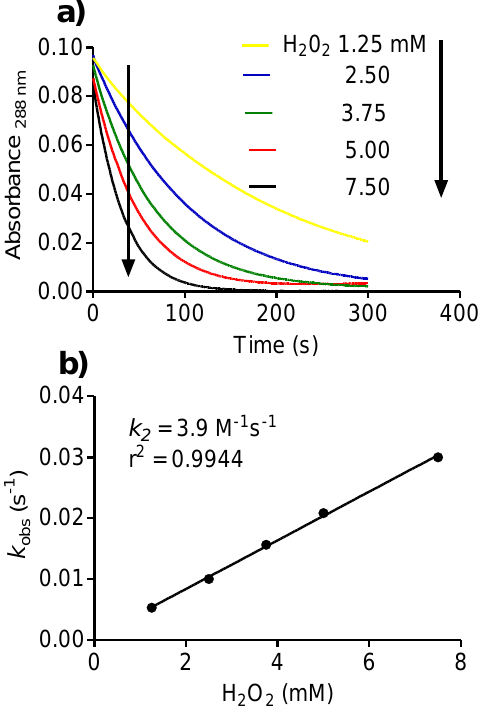
Figure 9. Reactivity of Tau-NHBr with H 2 O 2 . ( a ) Kinetic profile of Tau-NHBr consumption for determination of kobs under pseudo-first-order experimental conditions. The reaction mixture was composed of 250 µM Tau-NHBr and increasing concentrations of H 2 O 2 in 50 mM phosphate buffer, pH 7.0; ( b ) Determination of the bimolecular rate constant ( k 2 ) for the reaction between H 2 O 2 and Tau-NHBr.